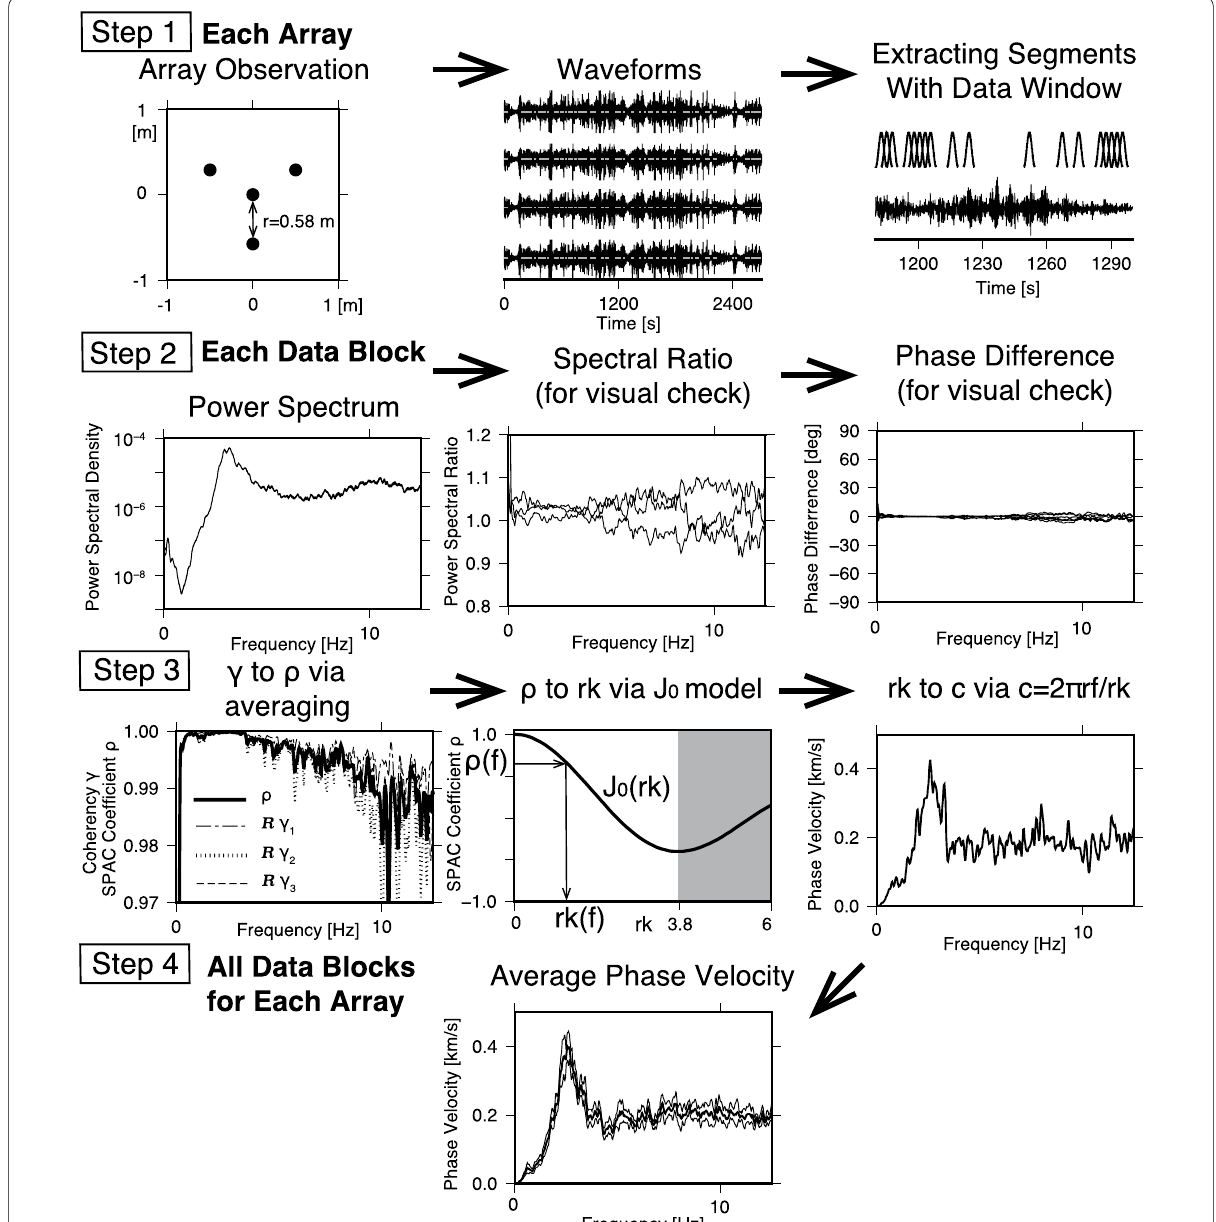
Fig. 3 Data processing workflow to obtain a phase velocity dispersion curve from each set of array data. The case of an array radius of 0.58 m of the BP data is shown as an